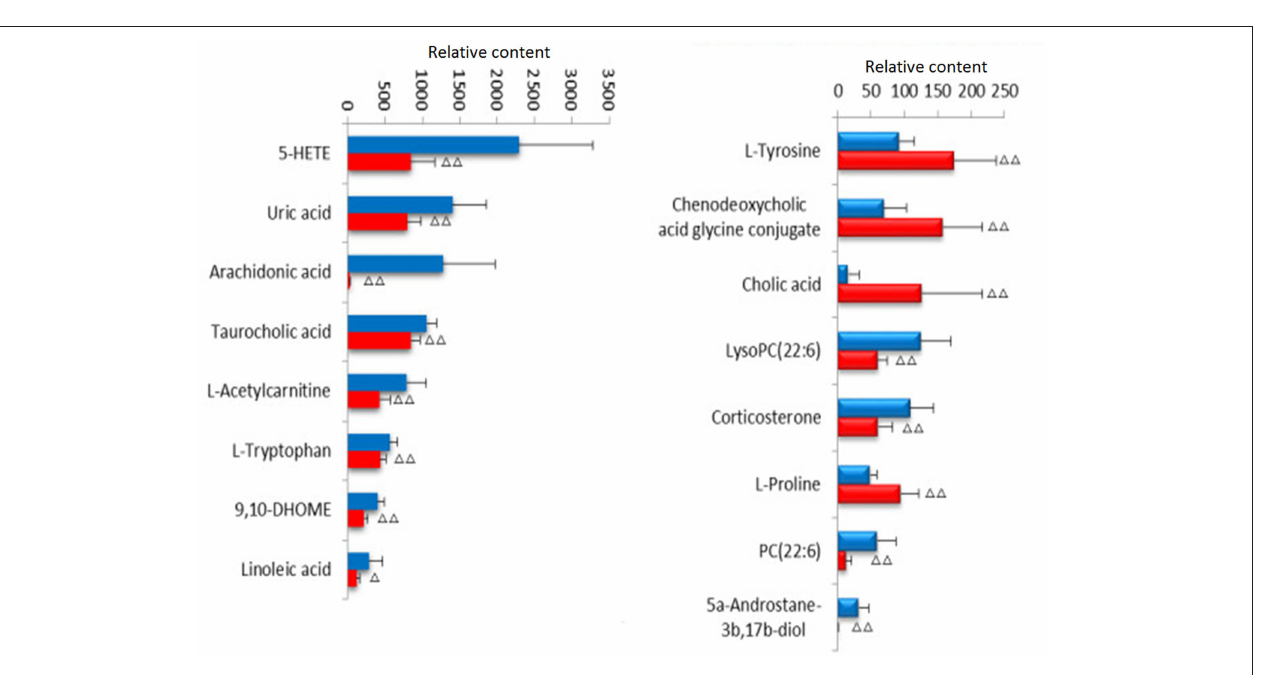
including Aminoacyl-tRNA biosynthesis; ubiquinone